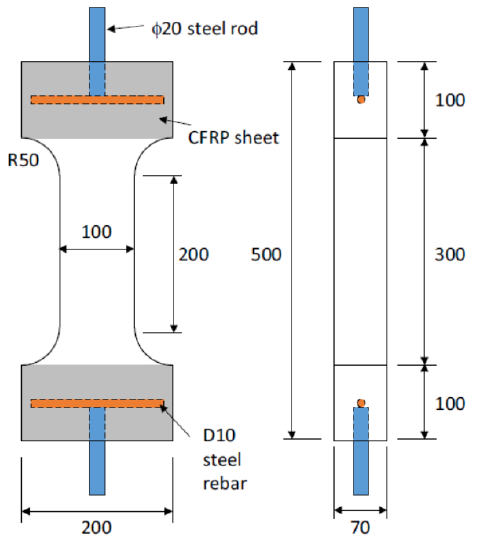
Figure 8. Details of the specimens tested by Lee et al. [20].